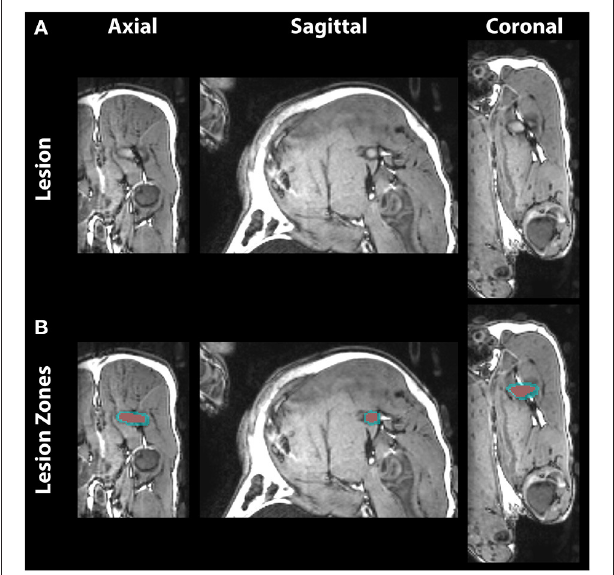
FIGURE 3 | Post-treatment T1-weighted images in axial, sagittal, and coronal view. (A) The lesion on the sciatic nerve shows distinct zones of hyperintense necrotic core and surrounding hypointense edema. (B) Lesion voxels were segmented into central zone I (red) and surrounding zone II